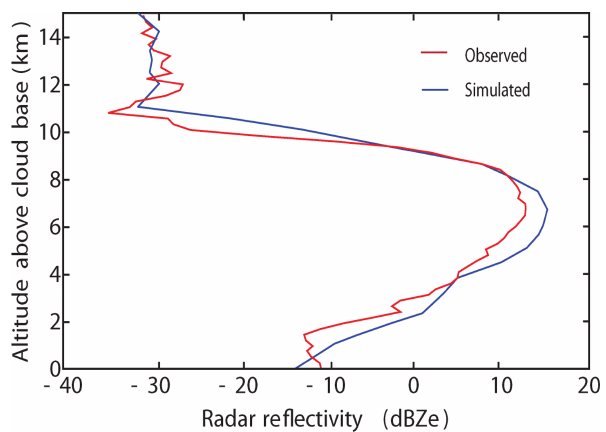
Figure 3. The vertical distribution of the radar reflectivity averaged along the Cloudsat path.